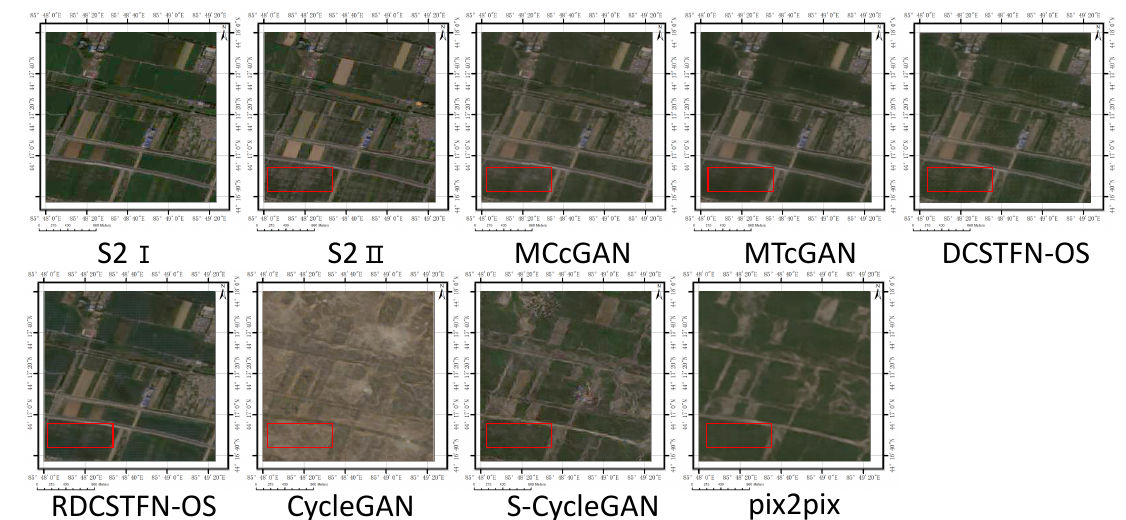
Figure 6. Comparison of different methods (image size: 256 × 256, MCcGAN: Multi-channels Conditional Generative Adver- sarial Network, MTcGAN: Multi-temporal Conditional Generative Adversarial Network, DCSTFN-OS: Deep Convolutional Spatiotemporal Fusion Network for SAR-to-Optical Task, RDCSTFN-OS: Residual Deep Convolutional Spatiotemporal Fusion Network for SAR-to-Optical Task, CycleGAN: Cycle-consistent Adversairal Network, S-CycleGAN: Supervised Cycle-consistent Adversairal